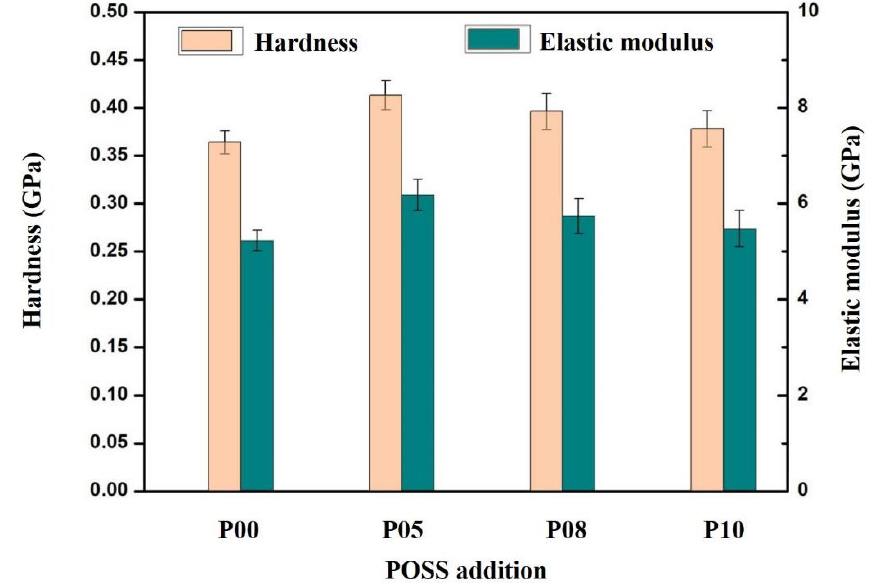
Figure 3. Hardness and elastic modulus of composite resins with different POSS additions.